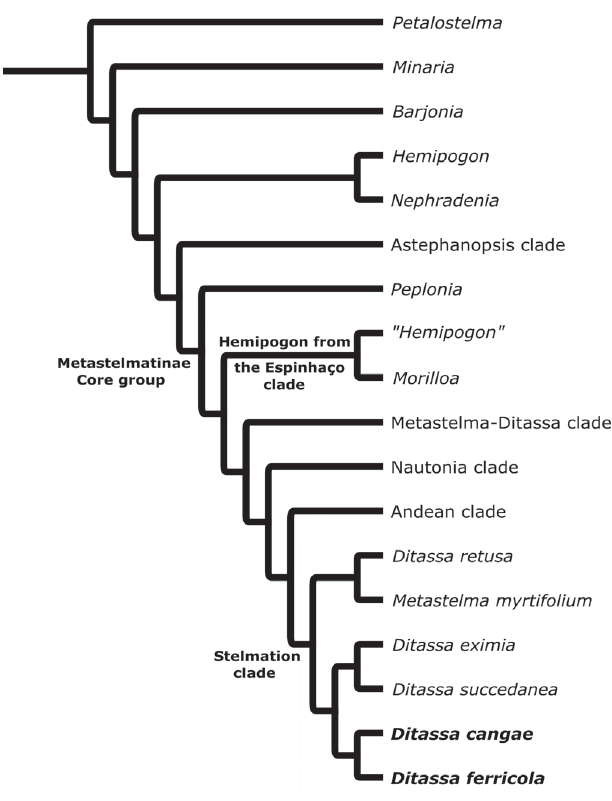
Figure 1 – Summary cladogram of Metastematinae (Apocynaceae) based on the phylogenetic analysis of 73 plastid-coding regions (Bitencourt 2019) to show the position of the new species Ditassa cangae and D. ferricola (in bold). All clades are highly supported (posterior probability ≥ 0.95). Clade names after Silva et al. (2012) and Liede-Schumann et al.